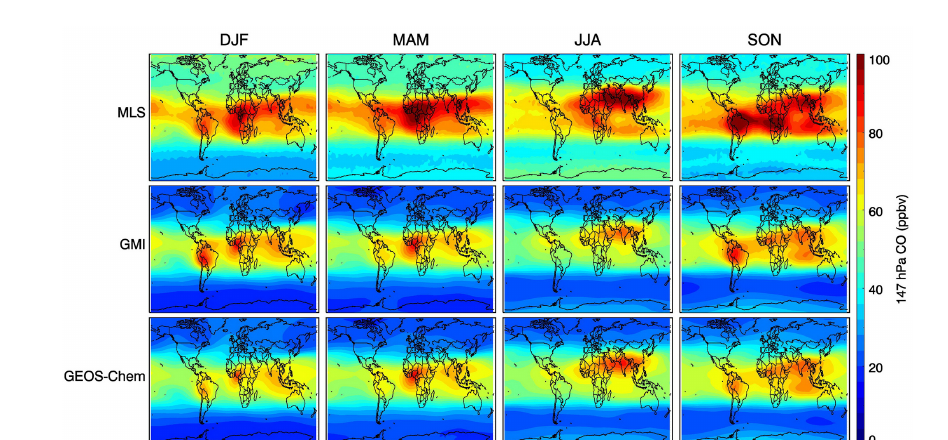
Figure 2. As in Fig. 1, but for CO mixing ratio at